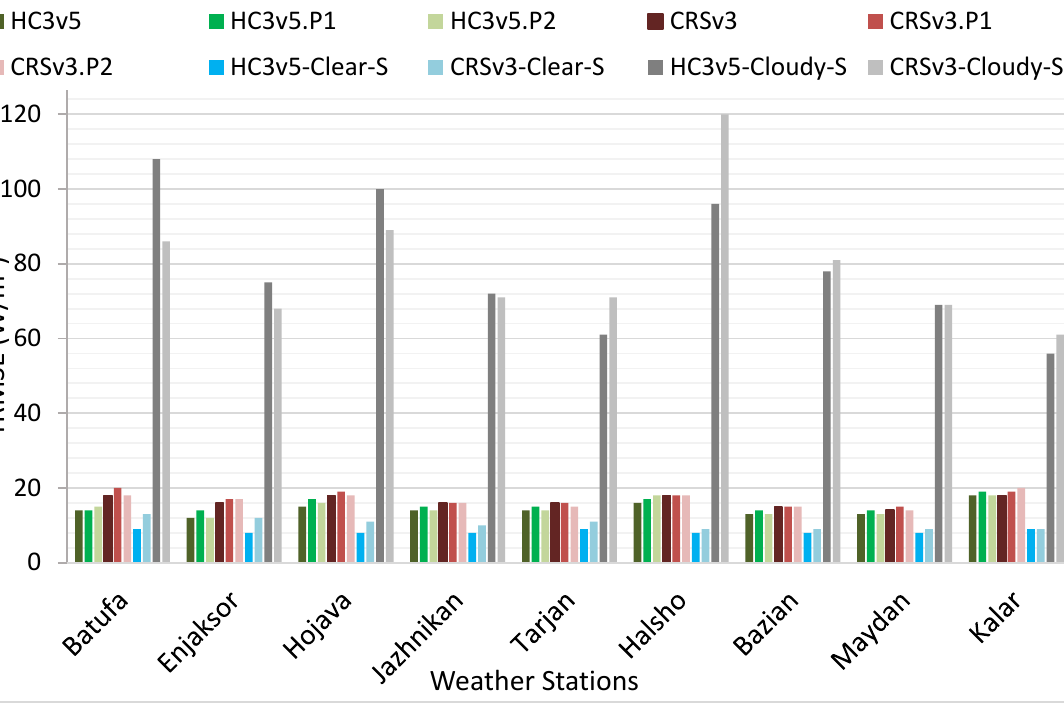
Figure 8. As in Figure 7, but for rRMSE.